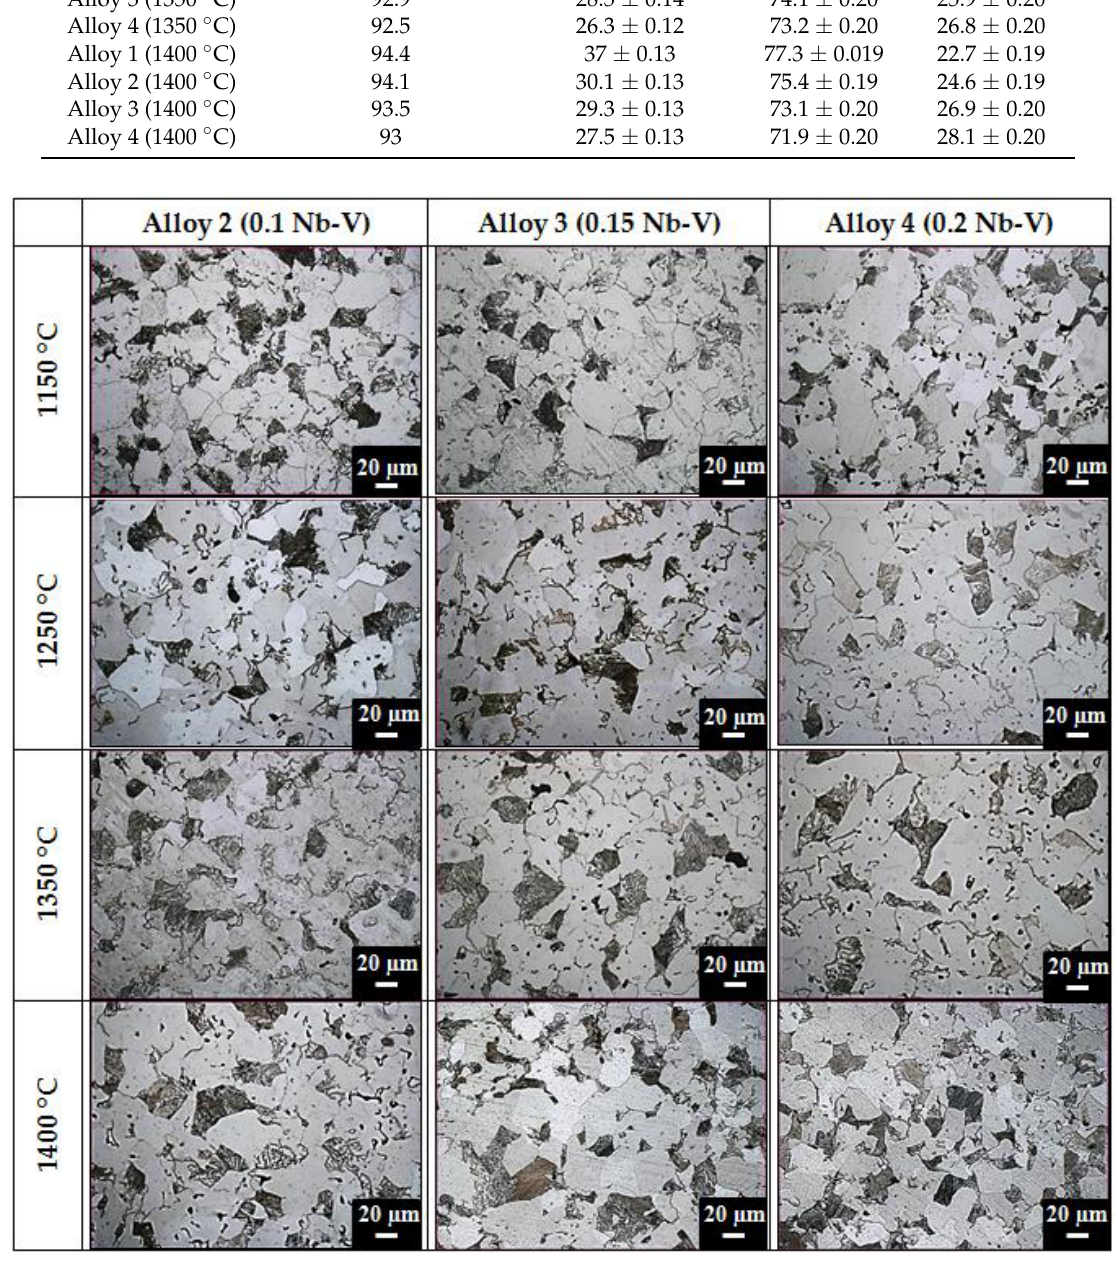
Figure 4. Micrographs of Nb-V PM steel specimens sintered at different temperatures (500×).